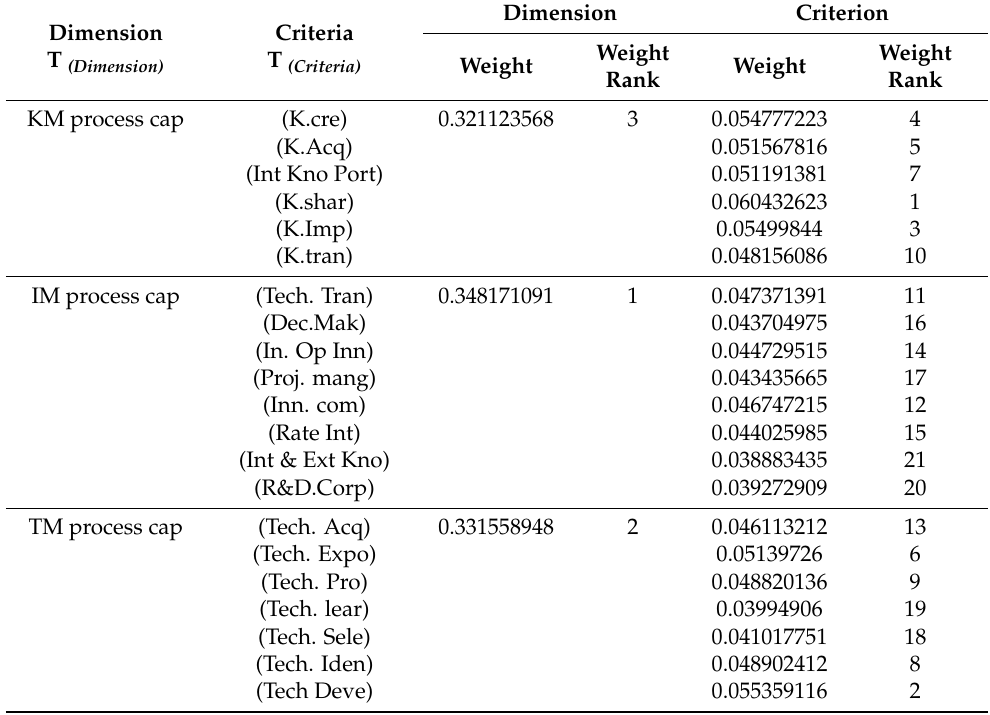
Table 13. The list of weight ranks for each dimension and criterion. Dimension Criteria T (Dimension) T (Criteria)